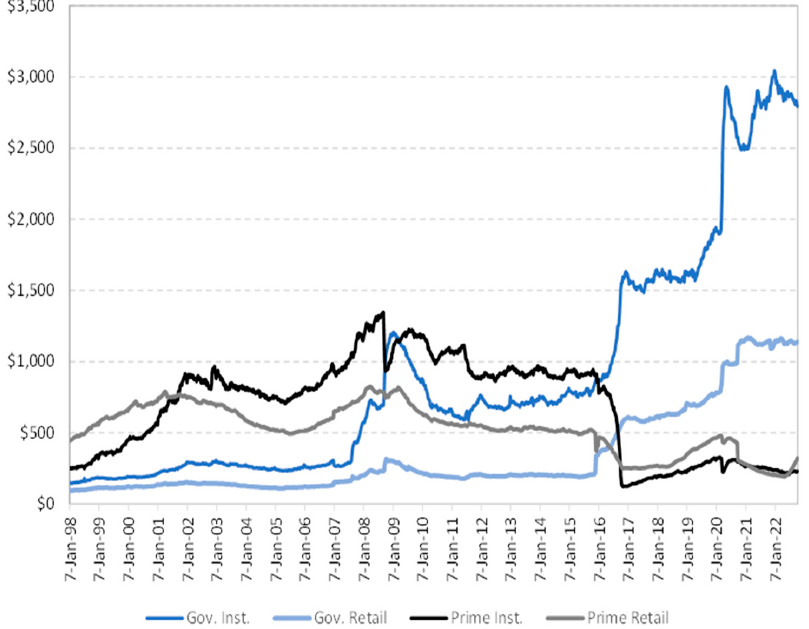
Figure 2. U.S. Money Market Funds Assets under Management (USD Billions). Source: Federal Re- serve.